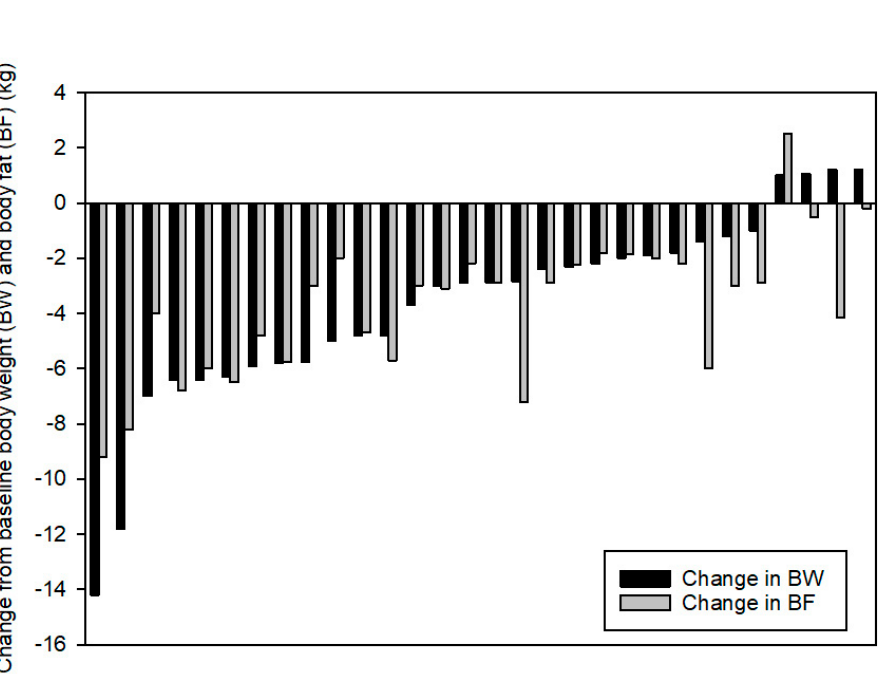
Figure 1. Individual body weight and fat mass changes following 12 weeks of supervised exercise. Each pair of histograms represents one participant. Reproduced with permission from Springer Nature: Springer Nature, International Journal of Obesity [16], Copyright (2008).